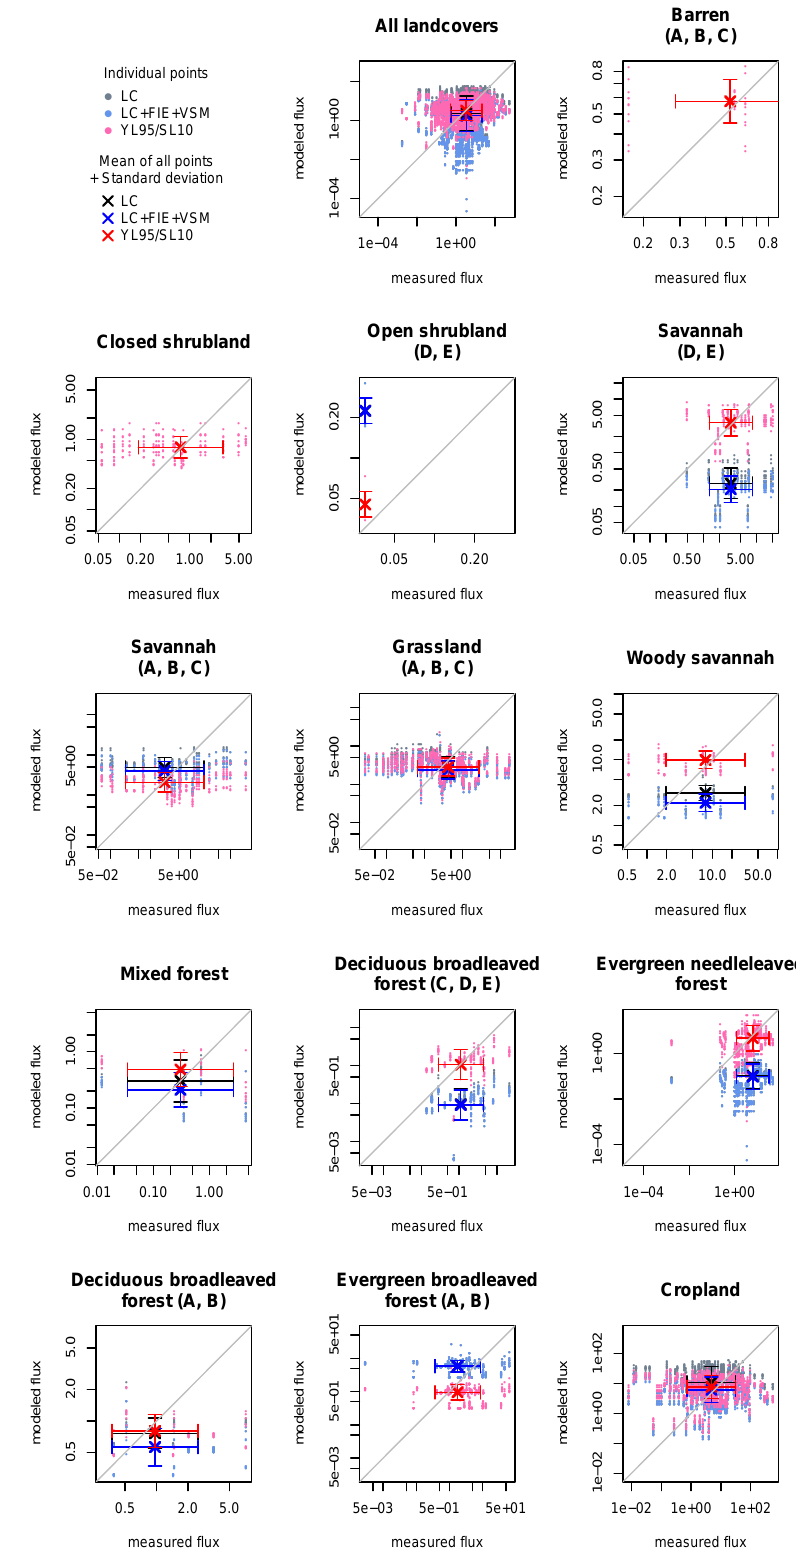
Fig. 13. Scatterplots of SNO x measurements versus model results for the YL95/SL11